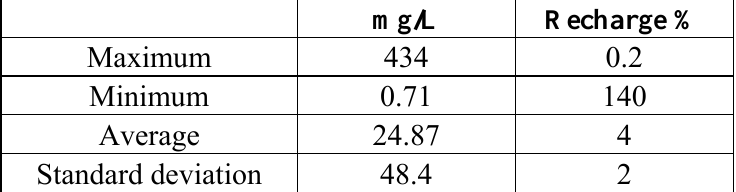
Table 2. Chloride concentration statistics in samples from the